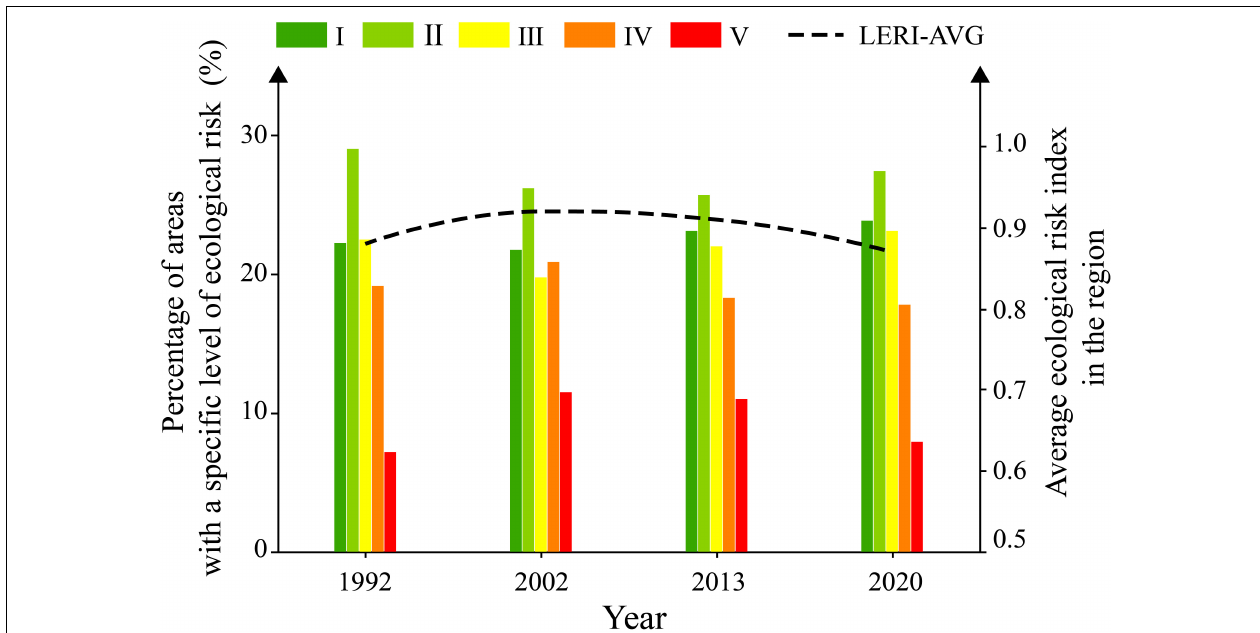
FIGURE 7 | Time series trend in ecological risk during the four periods at the Changshagongma Wetland Nature Reserve. TABLE 7 | q values of driving factors from 1992 to 2020 (%). Topography and geomorphology Climatic